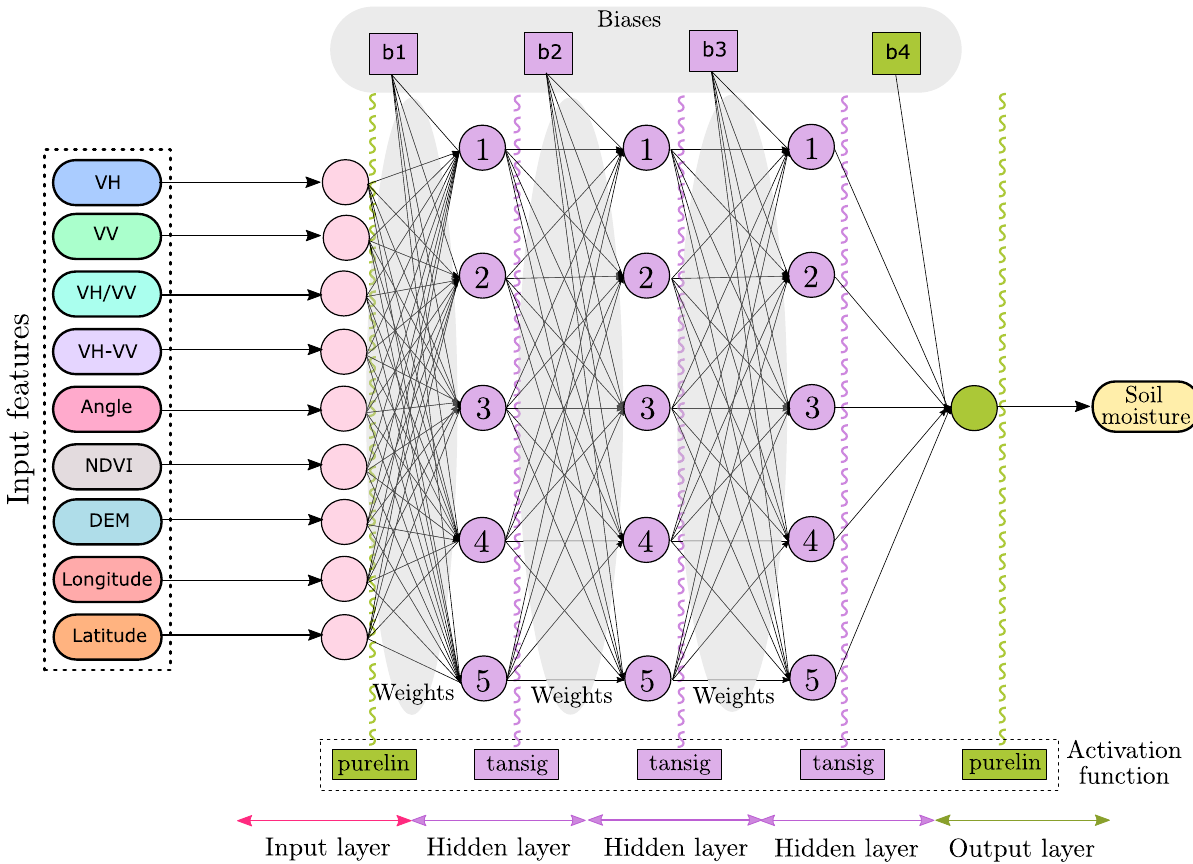
Figure 5. A fully connected 9-5-5-5-1 (I- H 1 - H 2 - H 3 -O) feed-forward ANN architecture for soil moisture estimation. I, H, and O represent the input, hidden, and output layers,